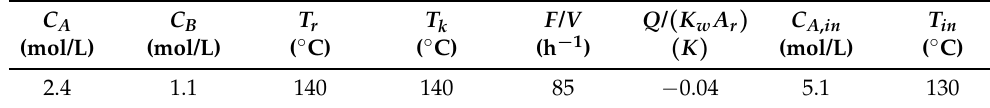
Table 2. Initial conditions used in the simulations.